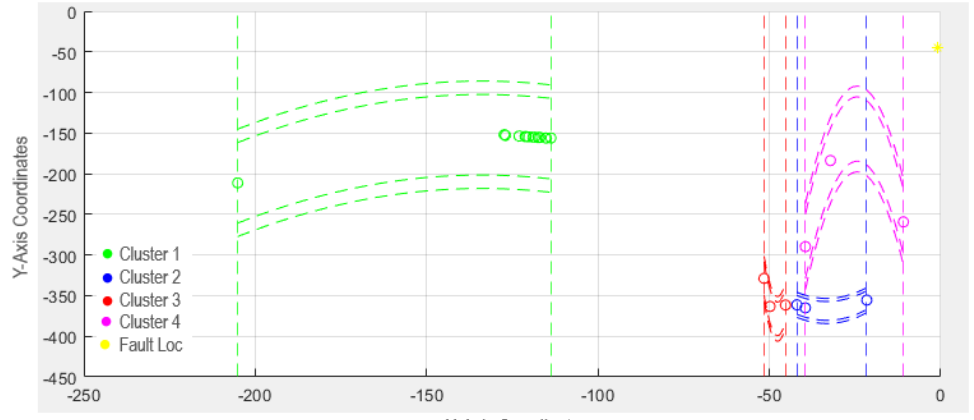
Figure 21. 100 Ω fault identified.